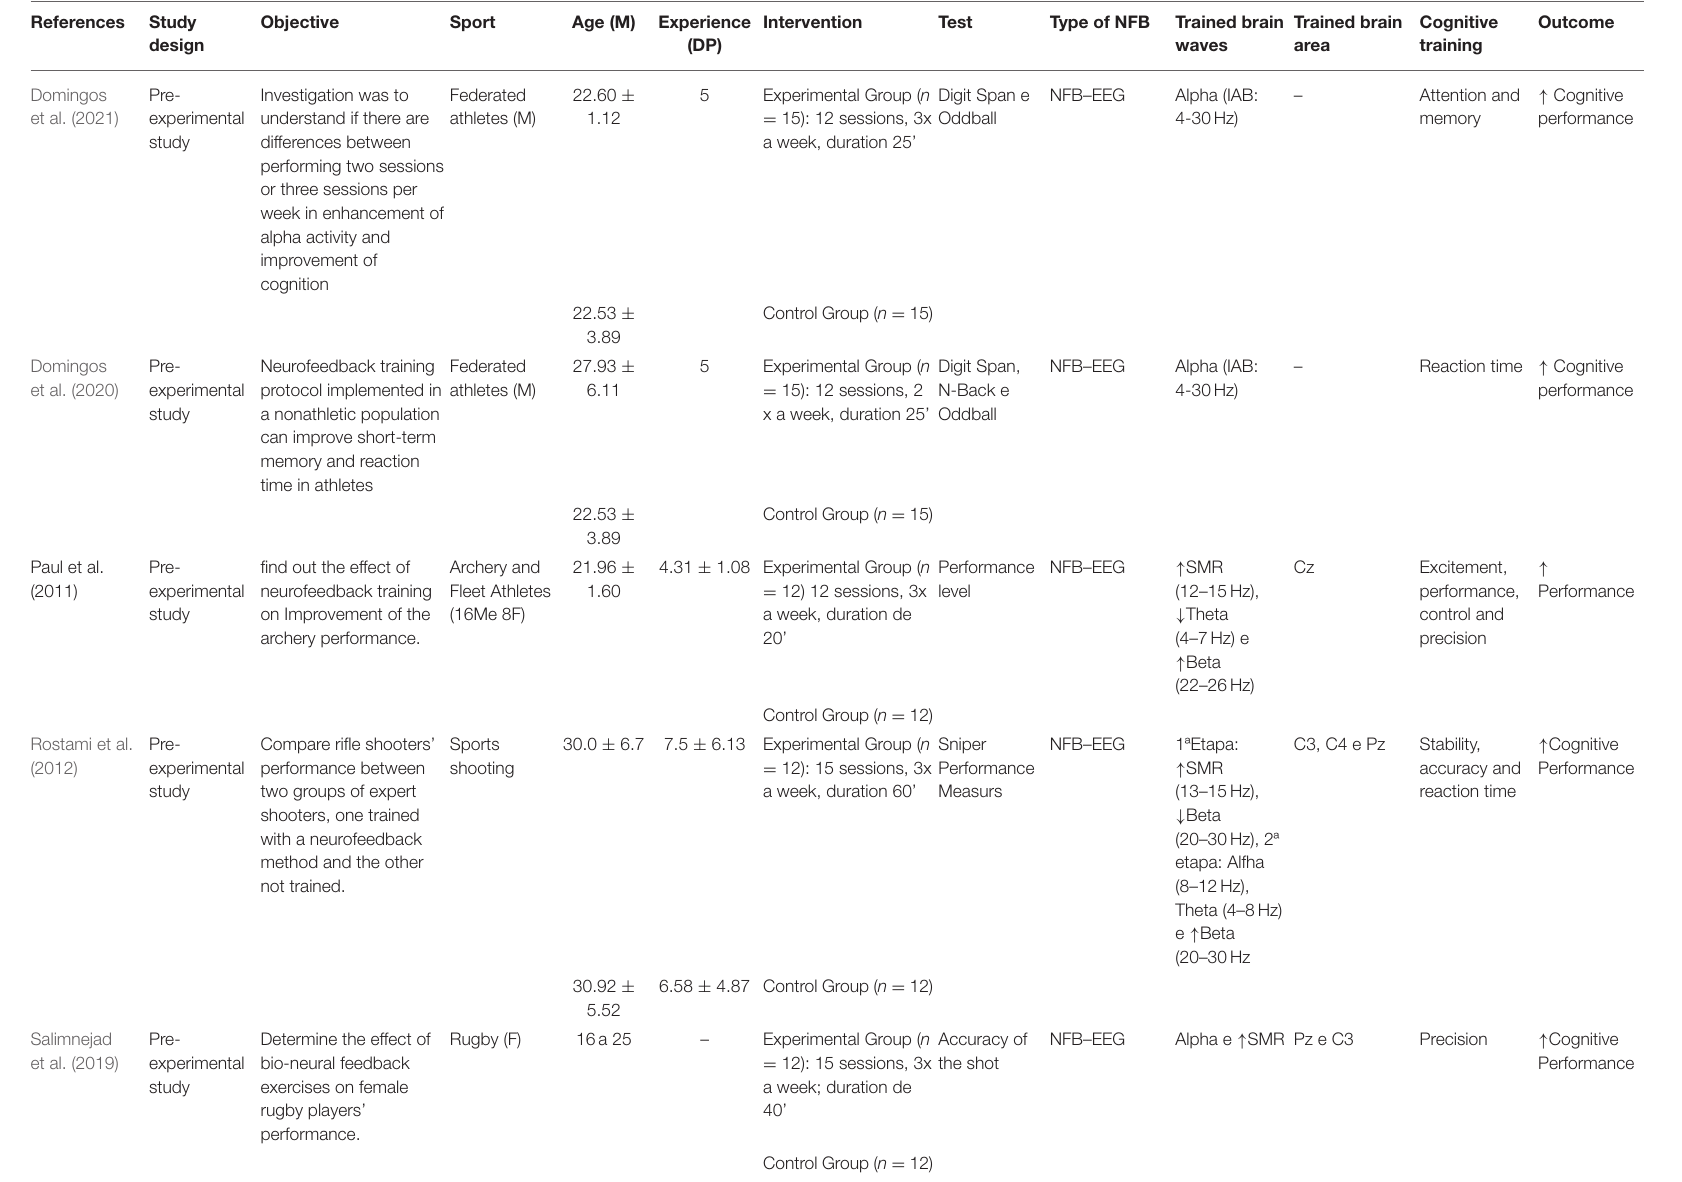
TABLE 4 | Characteristics of the studies included in the meta-analysis—cognitive performance and